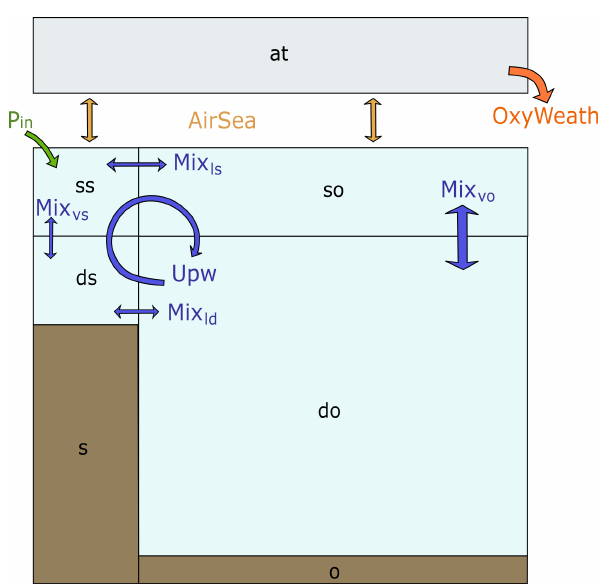
Figure 1. Box model scheme with a representation of the physical and boundary fluxes affecting inorganic tracers in the water column and atmosphere, where blue arrows indicate advective and mixing fluxes and yellow arrows indicate air–sea gas exchange fluxes. The model includes seven boxes: surface shelf (ss), deep shelf (ds), sur- face open ocean (so), deep open ocean (do), atmosphere (at), shelf sediments (s) and open ocean sediments